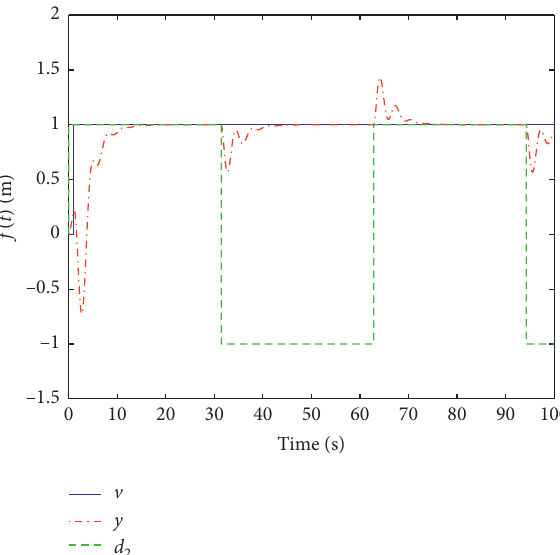
Figure 16: Control system response with disturbance signal d